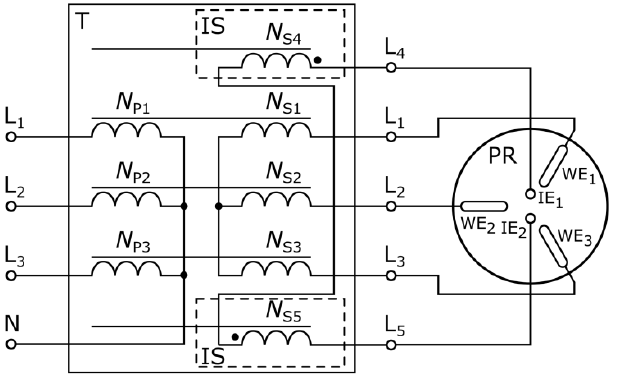
Figure 5. Power system with 5-column transformer IFCTPS, PR — plasma reactor, T — reactor working electrodes power circuit, IS — ignition electrodes power circuit, N P1 , N P2 , N P3 — primary windings, N S1 , N S2 , N S3 , N S4 , N S5 — secondary windings, WE 1 , WE 2 , WE 3 — plasma reactor working electrodes, IE 1 , IE 2 — reactor ignition electrodes.